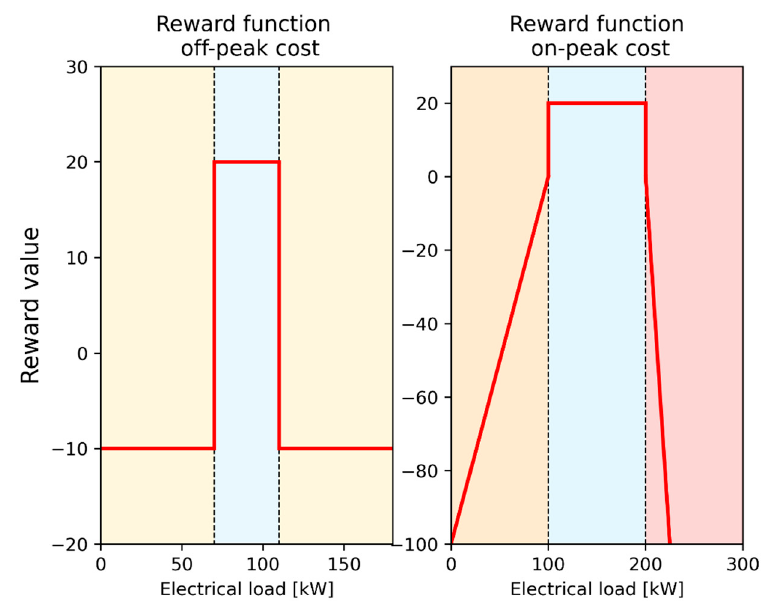
Figure 7. Evolution of the power term of the reward function. In particular, during off-peak periods, two thresholds were used to incentivize con- sumption between the 40th percentile ( th 1 ,off-peak ) and the 50th percentile ( th 2 ,off-peak ), rewarding (with a fixed prize term p P 1 ) or penalizing (with a fixed penalty term p P 2 ) the controller. This reward formulation penalizes low values of electrical load, associated with storage discharge or no usage, and high values of electrical load, which represent a